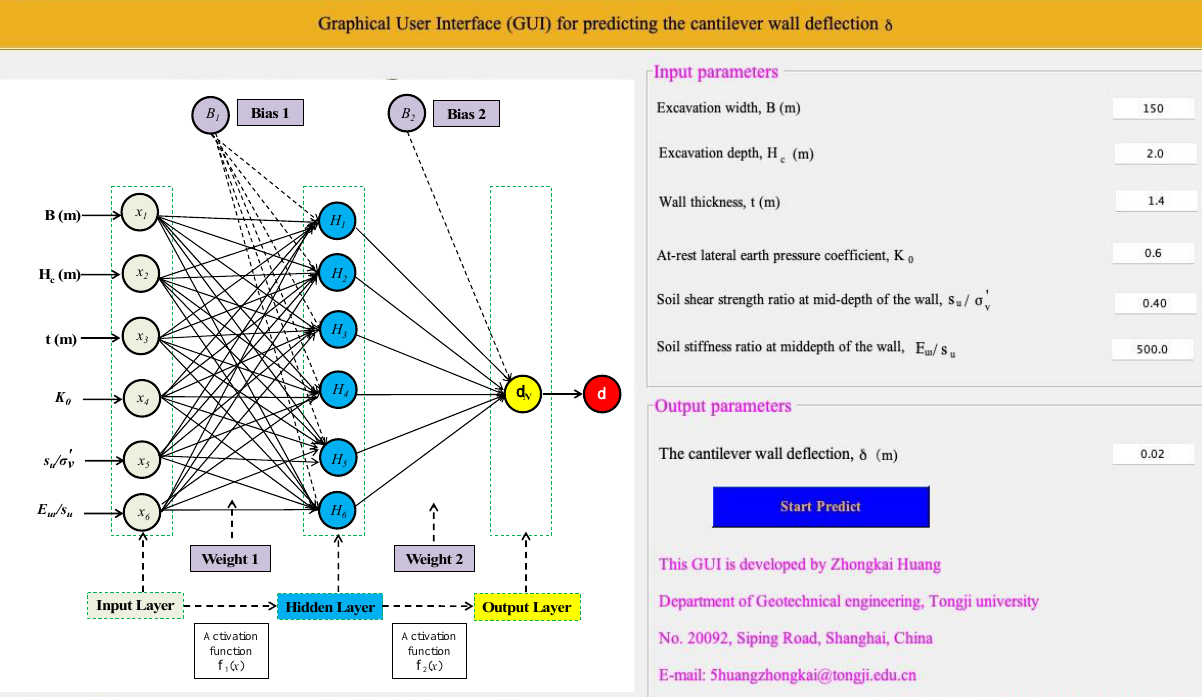
Figure 17. ANN interactive graphical user interface.